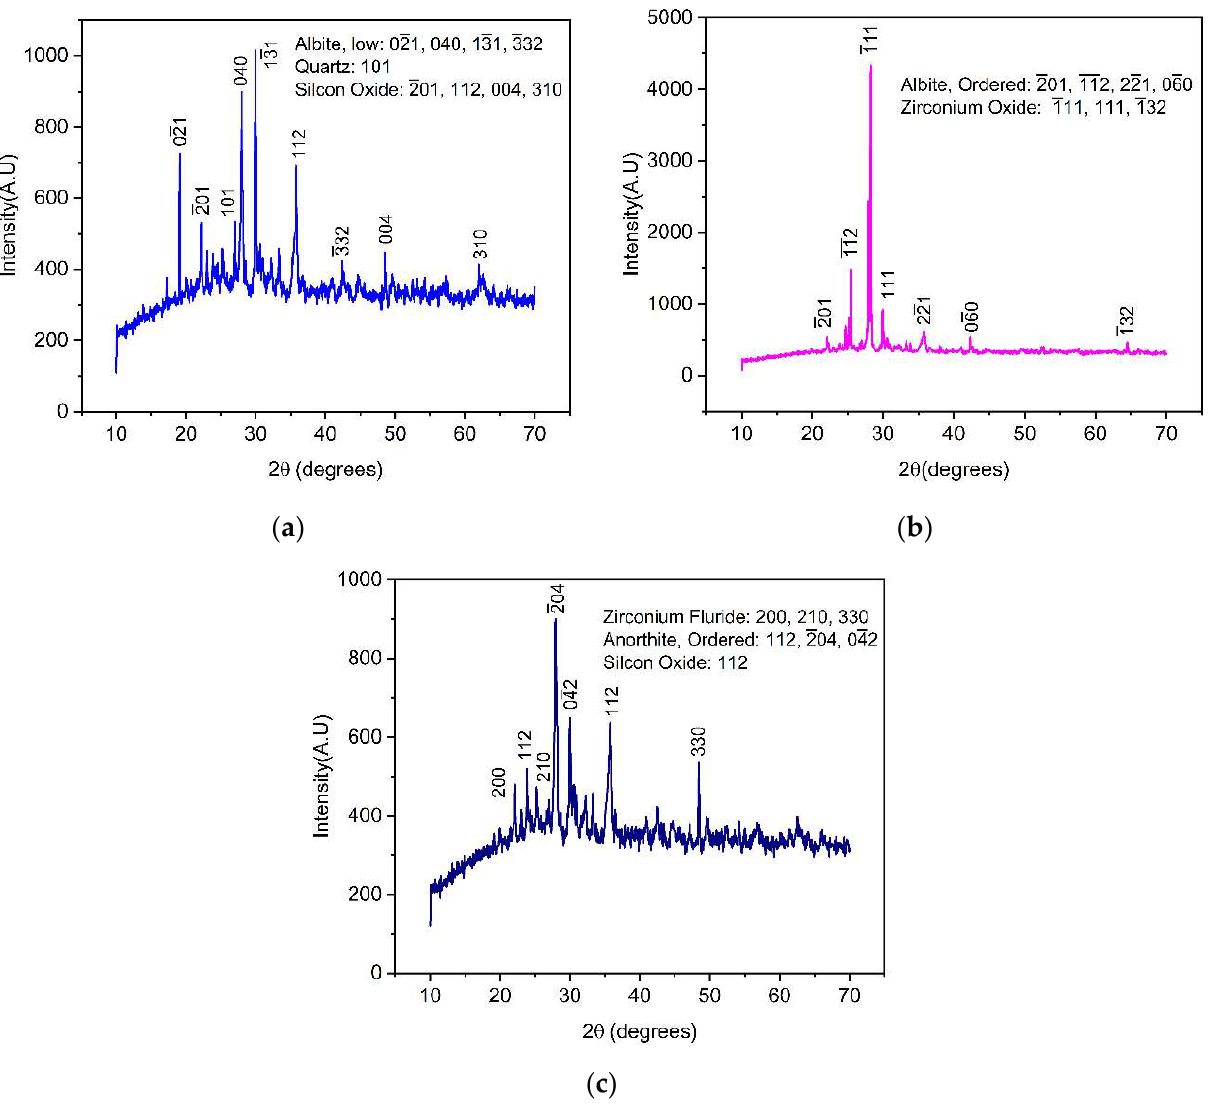
Figure 1. XRD patterns for ( a ) virgin scoria (VSco); zirconium oxide-coated scoria (ZrOCSc) ( b ) before and ( c ) after adsorption experiment.